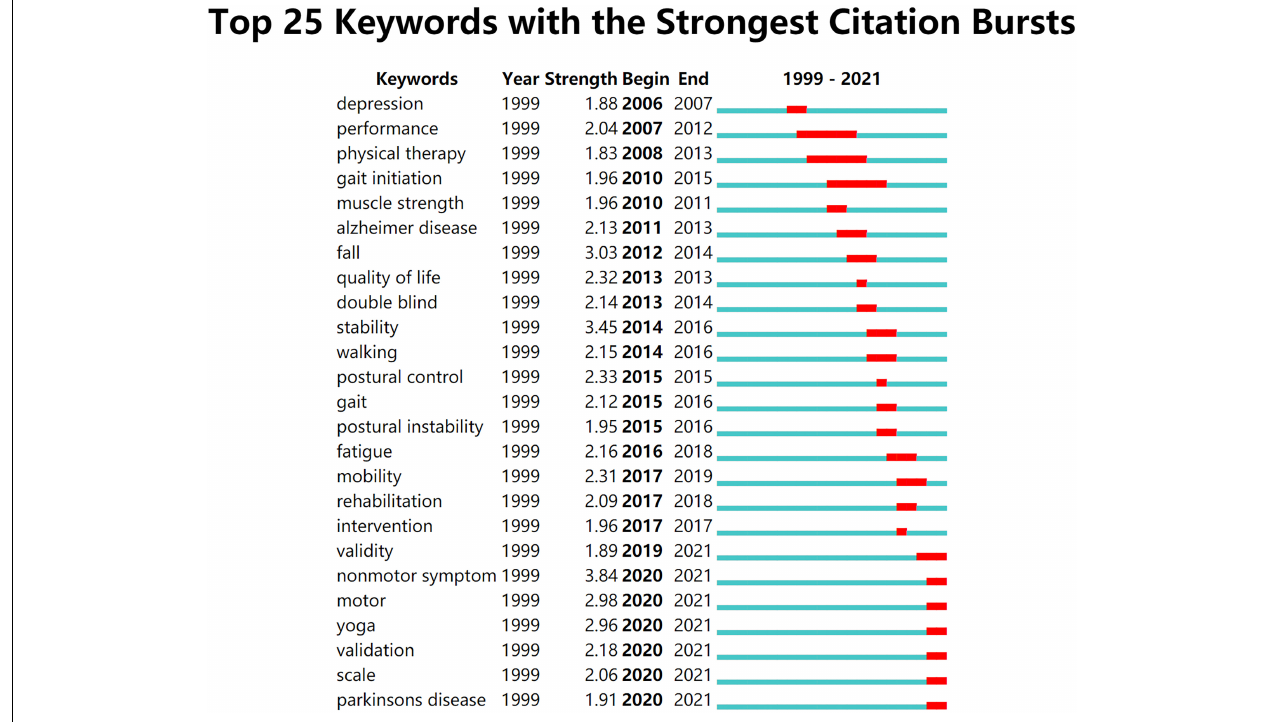
FIGURE 6 | Top 25 keywords with the strongest citation bursts. The timeline is depicted as a blue line, and the time interval that a subject was found to have a burst is shown as a red segment, which indicated the beginning year, the ending year, and the duration of the